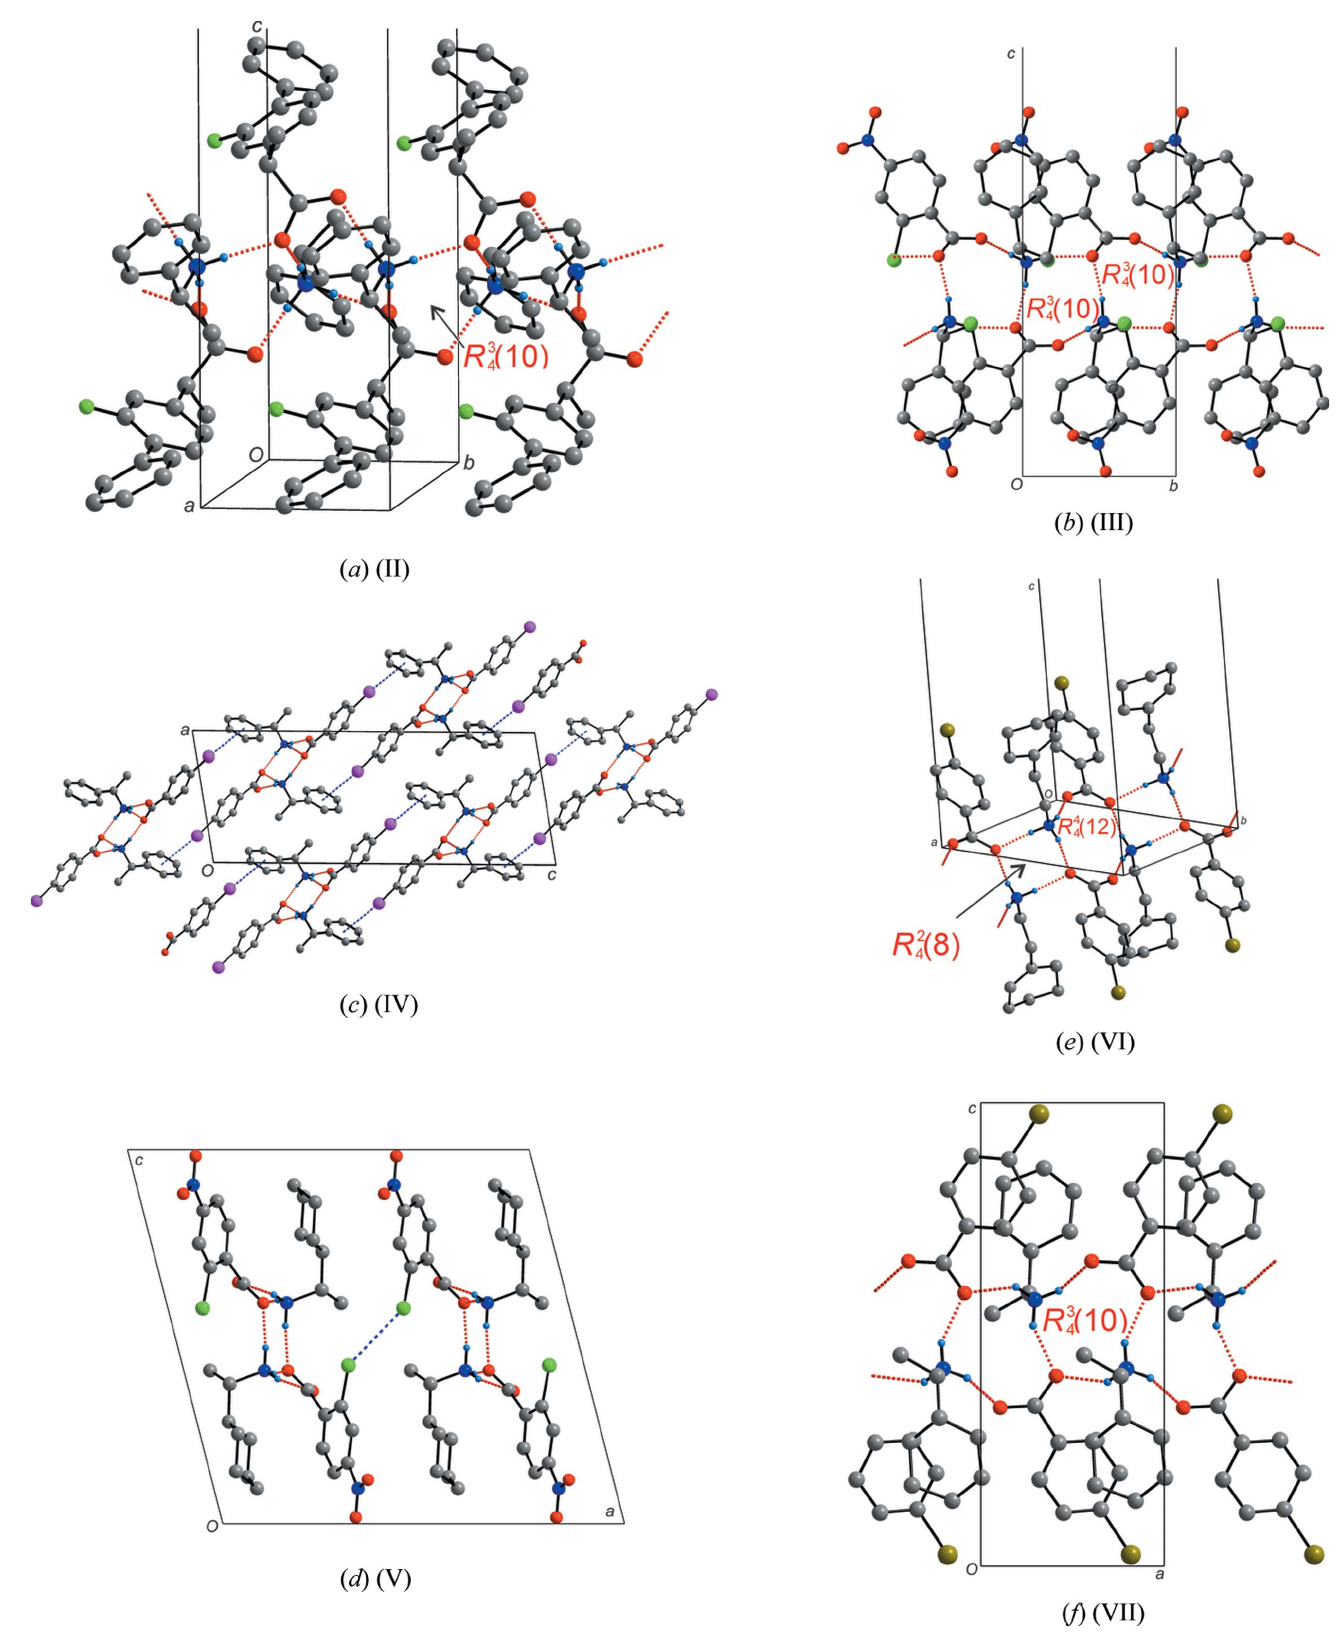
Figure 3 The hydrogen bonding (shown as dashed red lines), halogen bonding (shown as dashed blue lines) and packing diagrams for salts